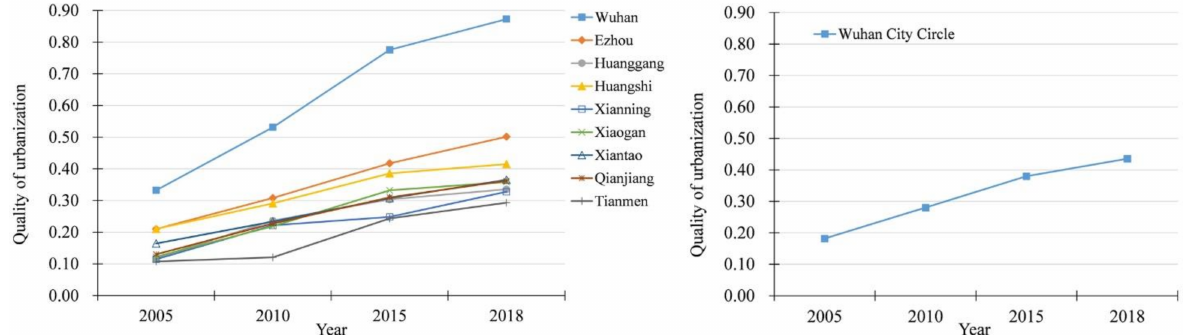
Figure 3. The changes of urbanization quality in Wuhan City